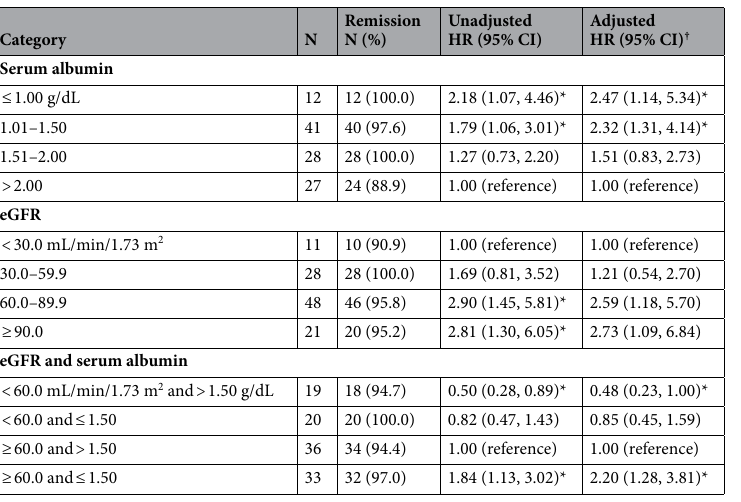
Table 3. Serum albumin, eGFR, and the incidence of remission. CI confidence interval, eGFR estimated glomerular filtration rate, IRR incidence rate ratio. *P < 0.05. † Adjusted for age (18–40, 41–64, and ≥ 65 years), sex, body mass index (kg/m 2 ), systolic blood pressure (mmHg), serum albumin (g/dL, if eGFR), eGFR (mL/min/1.73 m 2 , if serum albumin), urinary protein (log g/day or log g/gCr), dipstick hematuria (− or ±